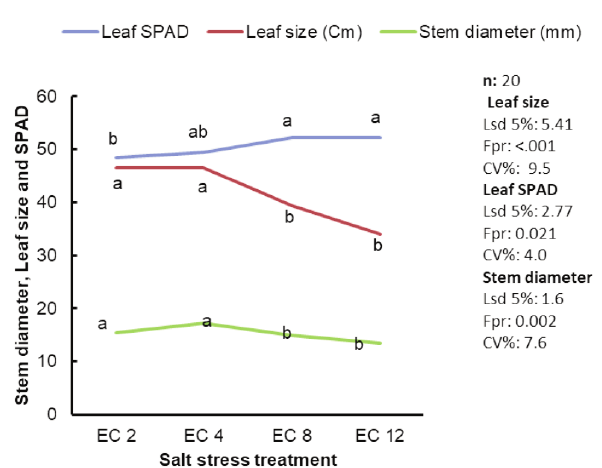
Fig. 3 ­ Effect of different concentration of “onsen” water on stem diameter, leaf size and SPAD of tomato plants variety ‘Reika’ in the greenhouse.